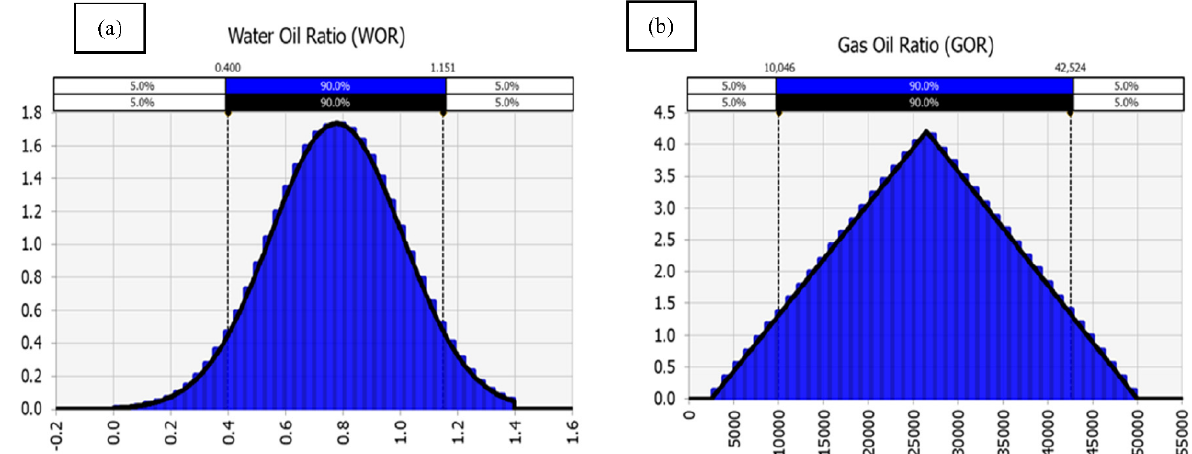
Figure 7. ( a ) Qualitatively scaled water saturation distribution of Jafurah basin (after Hakimi et al. [17,18]. ( b ) Normalized frequency obtained by digitization of plotted with the midpoint of each histogram porosity column. ( c ) Distribution of formation water saturation. ( d ) Distribution of fracture water saturation.